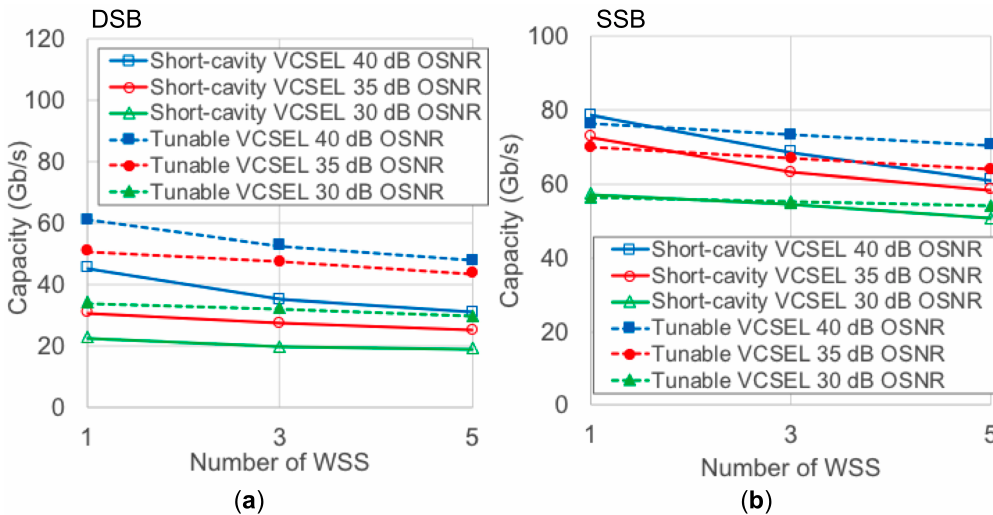
Figure 6. Transmission capacities vs number of crossed WSS for: 40 ‐ dB OSNR (blue square), 35 ‐ dB OSNR (red circle), 30 ‐ dB OSNR (green triangle), and short ‐ cavity VCSEL (continuous line open symbols), tunable VCSEL (dashed line full symbol) ( a ) DSB DMT modulation; ( b ) SSB DMT modulation.